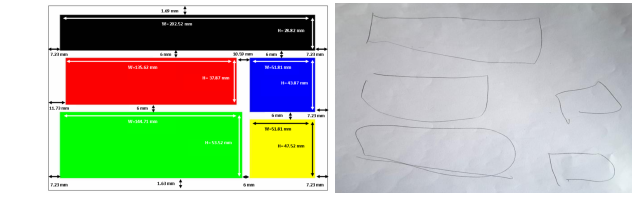
Figure 12. Sample drawings of D2 in reference to the news structure.